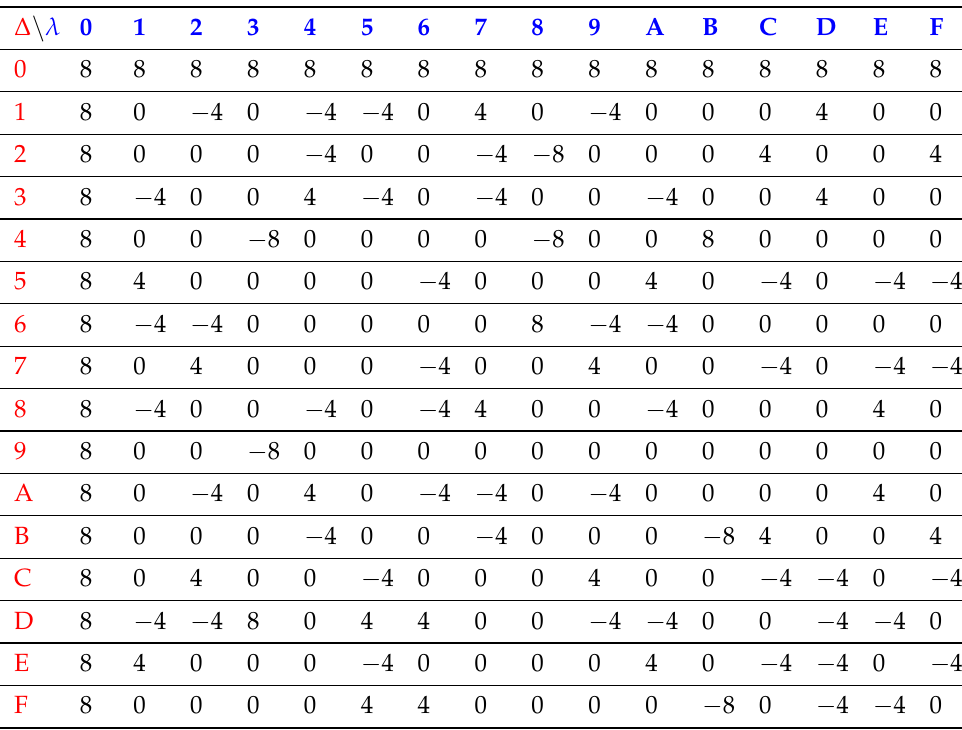
Table 9. The DLCT of the Serpent’s first S-Box S 0 ( X )